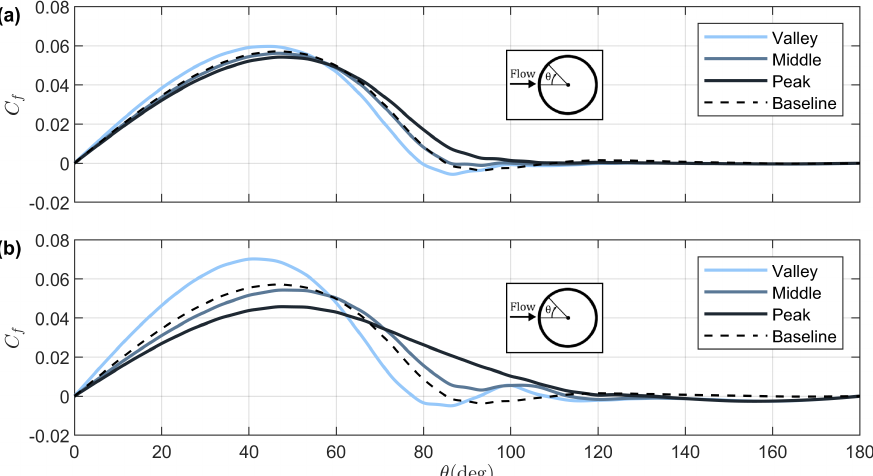
Figure 9. Sectional mean C f distributions for A03 ( a ) and A11 ( b ). A dashed curve denotes the baseline C f .